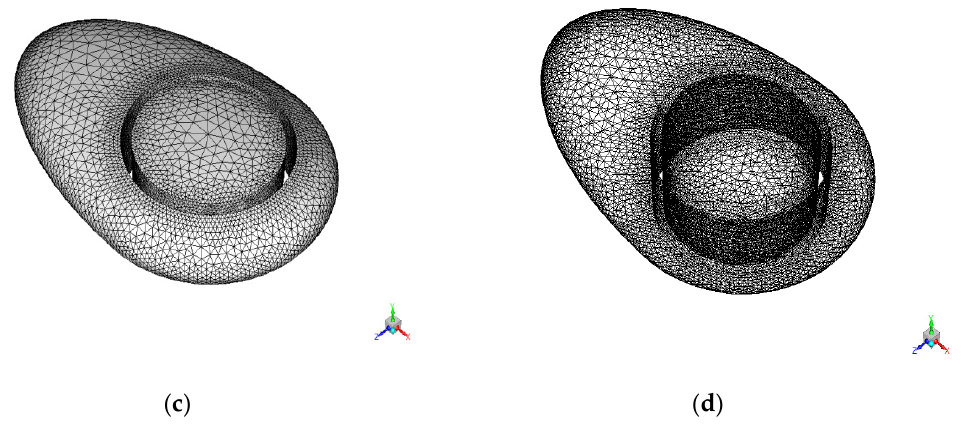
Figure 4. Meshed airship ( a ) baseline model and various circular slot ratios: ( b ) δ = 0.025, ( c ) δ = 0.0416, and ( d ) δ = 0.0583. Table 2. Boundary Conditions.